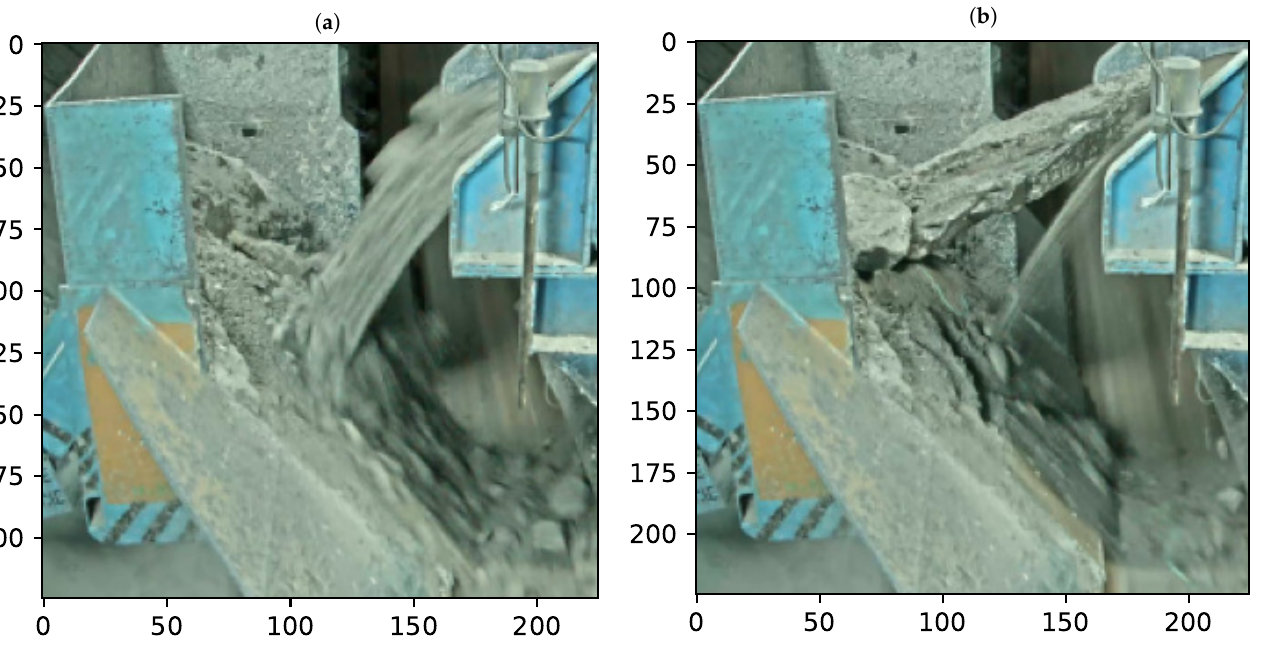
Figure 5. Original images after cropping and resizing: ( a ) normal working condition; ( b ) blockage